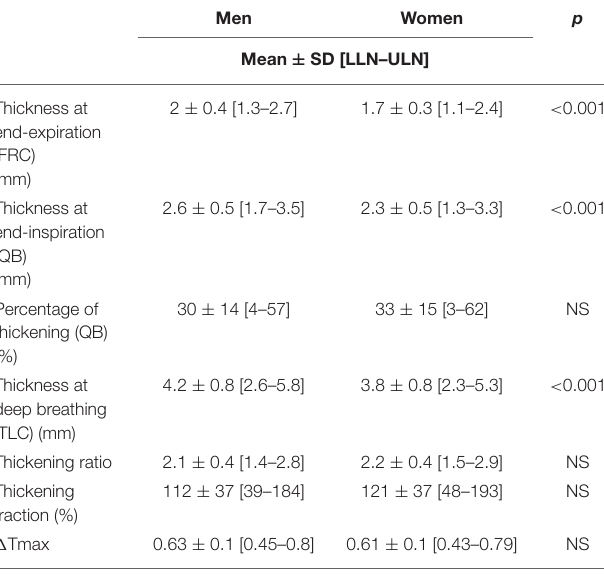
TABLE 3 | Study of the left